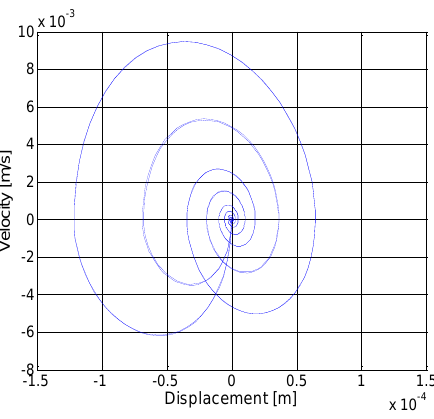
Fig. 19. Phase plane representation: Llinear case. Fig. 20. Phase plane representation: Nnonlinear case.